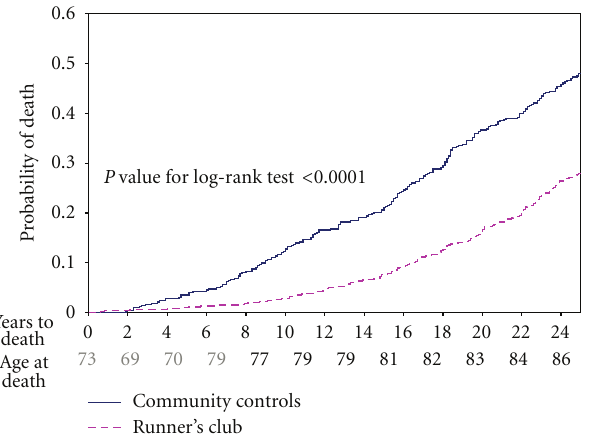
Figure 3: Kaplan-Meier analysis, Runner’s and community